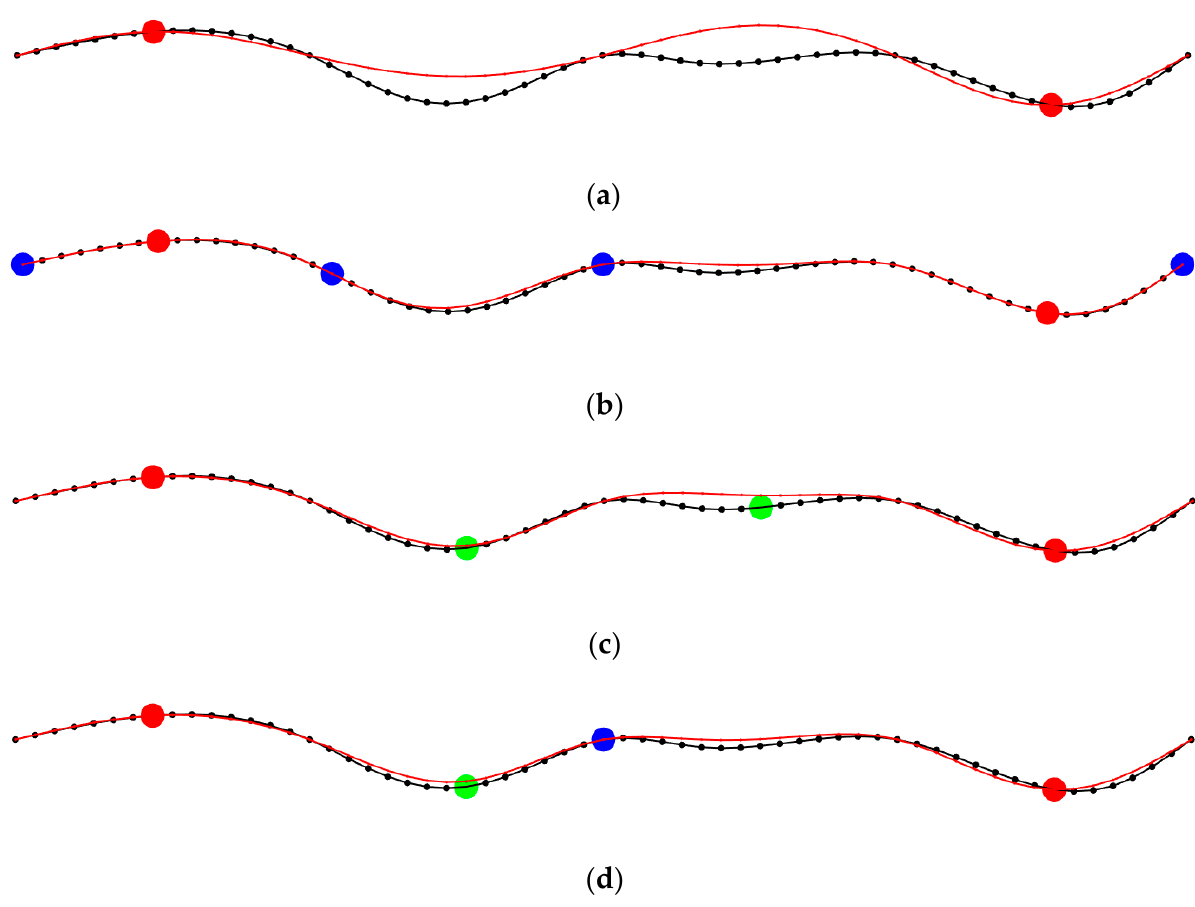
Figure 19. Example of estimated deformed shape according to the sensor number and combination (RDS4): ( a ) number of data ( ω = 2 ); ( b ) number of data ( ω = 2, ∅ = 4 ); ( c ) number of data ( ω = 2, ε = 2 ); ( d ) number of data ( ω = 2, ∅ = 1, ε = 1 ).